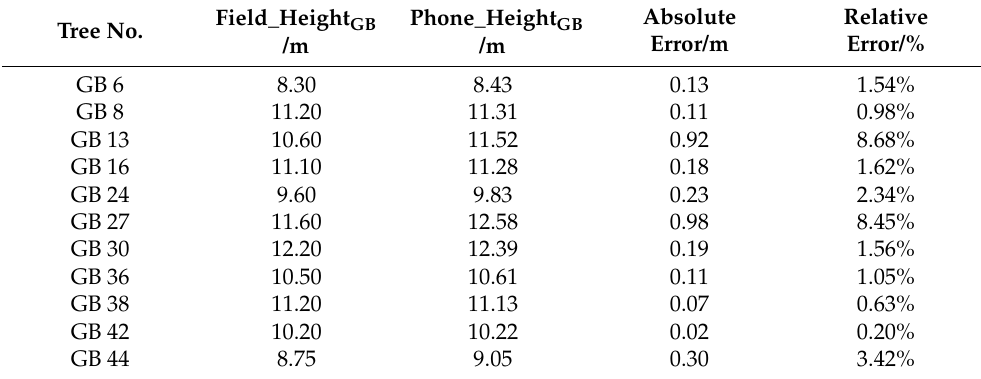
Table 1. The Field_Height GB , Phone_Height GB and error analysis. Tree No.